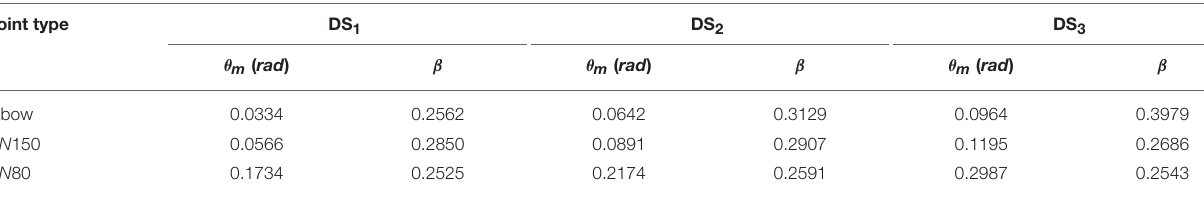
TABLE 2 | Summary of fragility